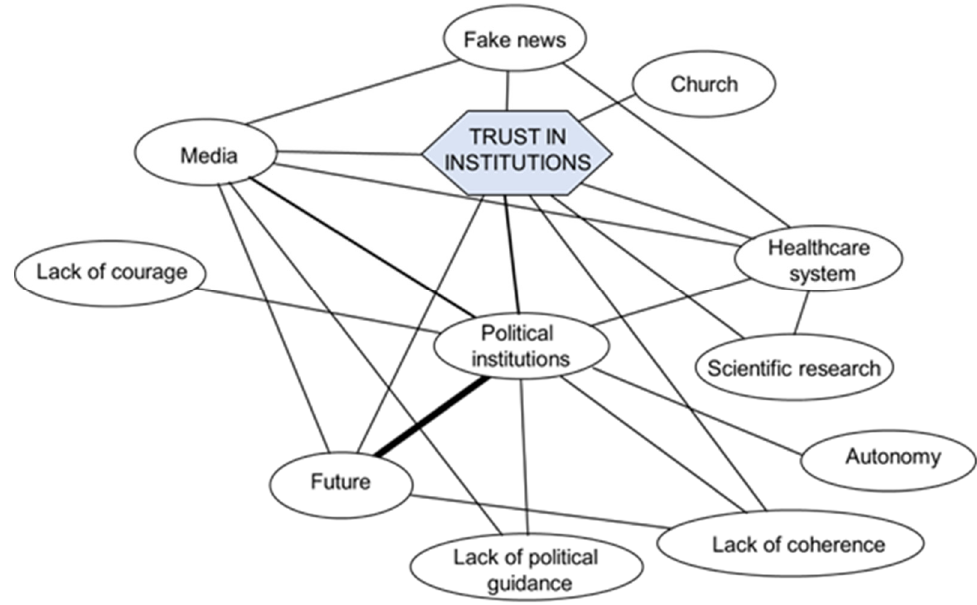
Figure 5. Trust in institutions (N = 14, expansion factor = 1).